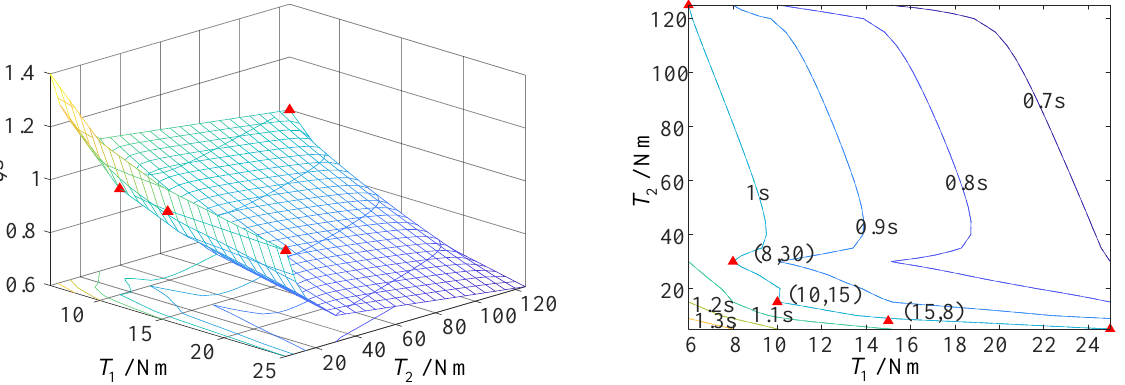
Figure 18. The curve of driving torque and deployment time of folding wing at an airspeed of 30 m/s (non-fixed-axis – fixed-axis stepwise deployment mode). When the non-fixed-axis – fixed-axis stepwise deployment mode is adopted and the airspeed is 40 m/s, the minimum driving torque required by axis 1 to complete the action is 15 Nm, and that required by axis 2 to complete the action is 8 Nm, on the premise that the folding wing can complete the action within 1 s, as shown in Figure 19.